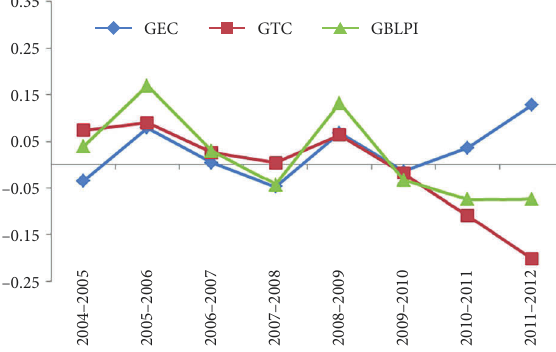
Figure 3. Trends in BGLPI, GEC and GTC of the